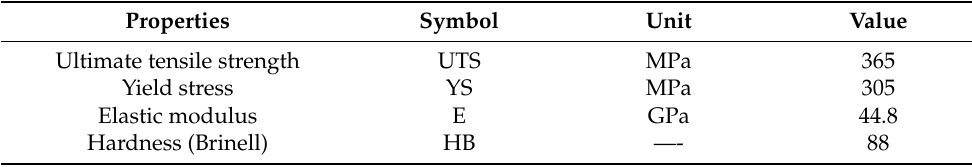
Figure 13. Effectiveness of various methods (REE and ECAP) to improve the fatigue life of AZ91 magnesium alloys “Reused with permission from Elsevier by License No. 5494640246452” [104]. ( a ) Effects of REE on fatigue life; ( b ) Effect of ECAP on fatigue life. Table 11. The summary of novel research on the AZ91 magnesium alloys. 5. Effect of Simultaneous Addition of Zinc and Zirconium Elements (Mg-Zn-Zr) ZK60 alloys have proper machinability and light weight, and while they are prone to corrosion, they are anodized to avoid this destructive phenomenon. The main chemical compositions of ZK60 alloy are magnesium, zinc, and zirconium. The mechanical properties of ZK60 magnesium alloy are given in Table 12. Table 12. Mechanical properties of ZK60 magnesium alloy